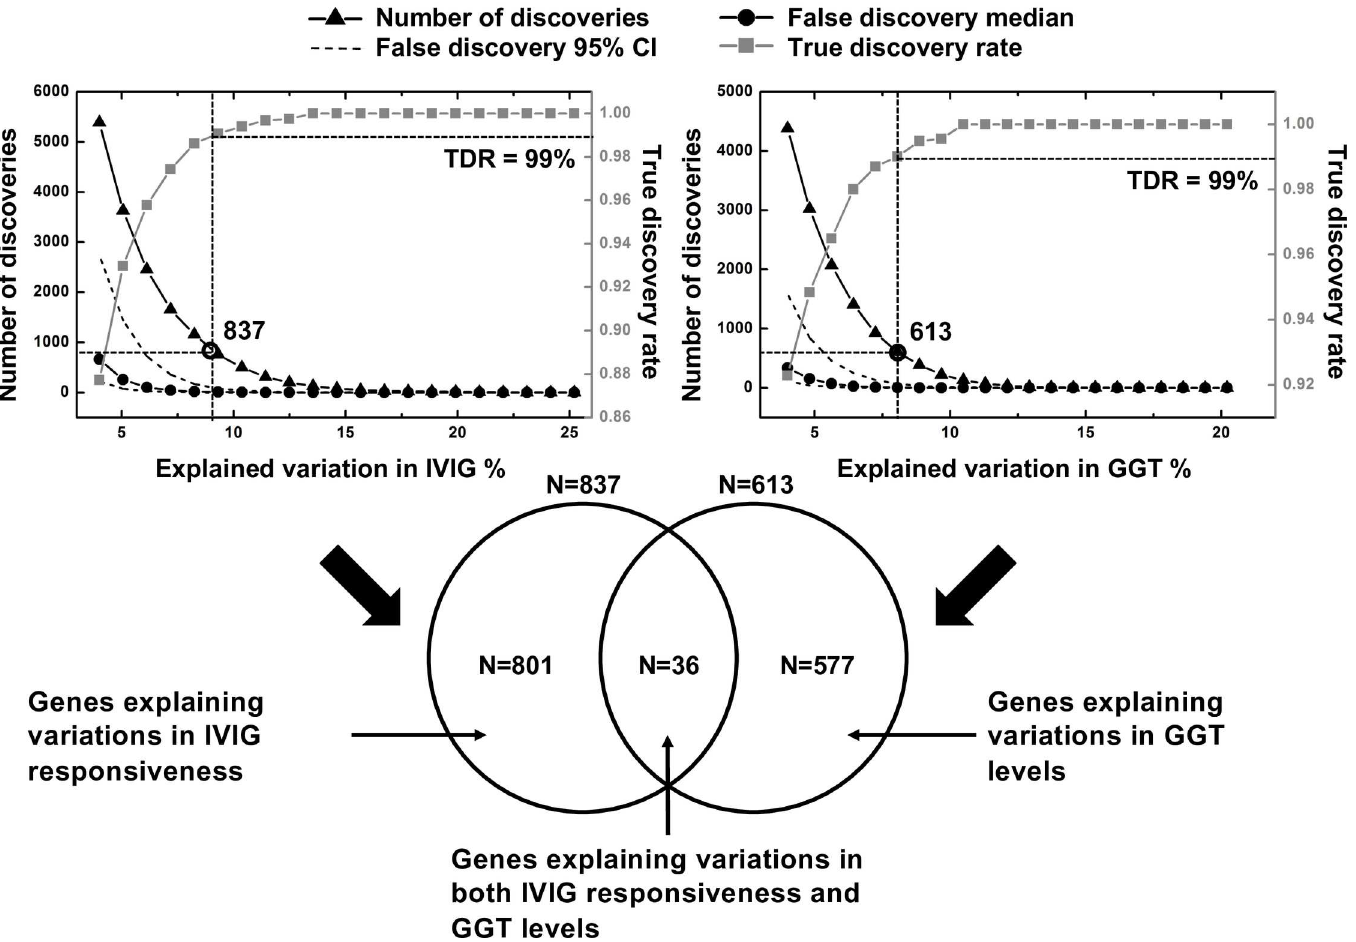
Fig 3. R 2 statistic and FDR analyses with respectto GGT levels and IVIG responsiveness. Top left panel:discovery of genesexplainingvariationsin IVIG responsiveness. Top right panel: discovery of genes explaining variationsin GGT levels. Bottom panel: Venn diagramanalysisuncoveringgenes explainingvariations in both IVIG responsiveness and GGT